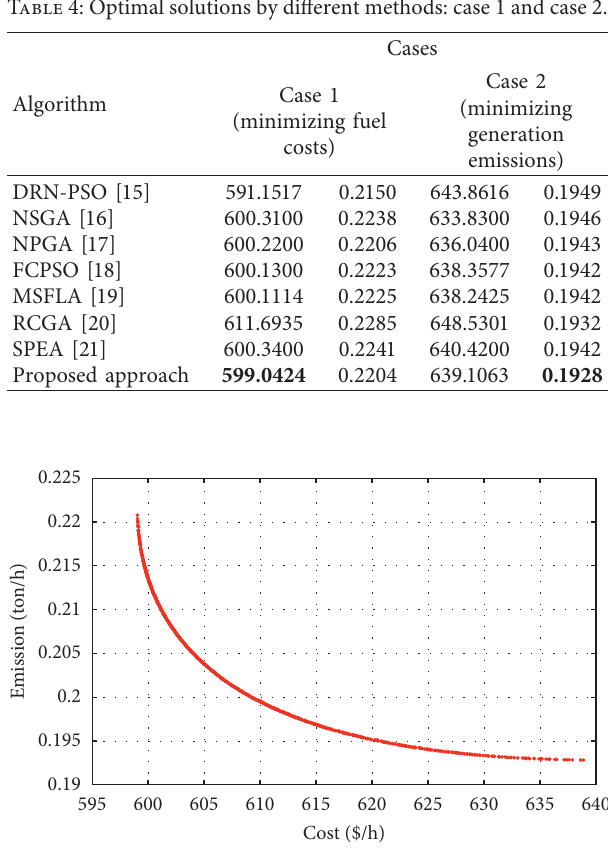
Figure 6: CEEDP Pareto optimal set obtained by the proposed